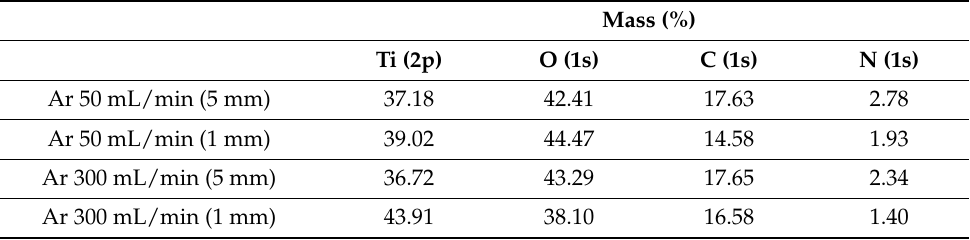
Table 1. Difference in atomic percentage of Ti, O, C and N elements at different deposition conditions. Distance between the plasma jet and a substrate are shown in the parenthesis.